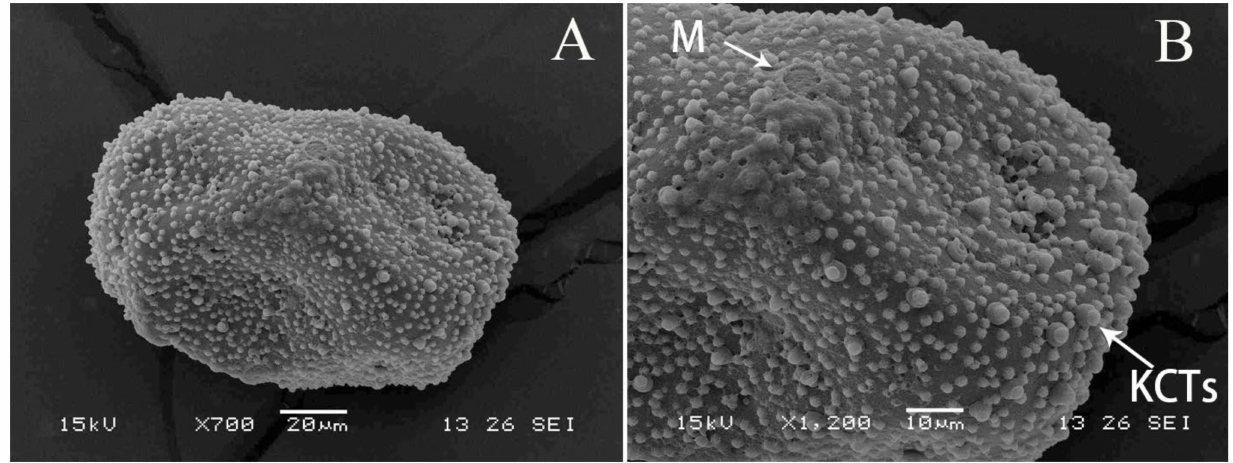
Figure 9. SEM photos of egg: ( A ) whole picture; ( B ) surface enlarged. M = Micropyle; KTC = Knob-terminated coiled